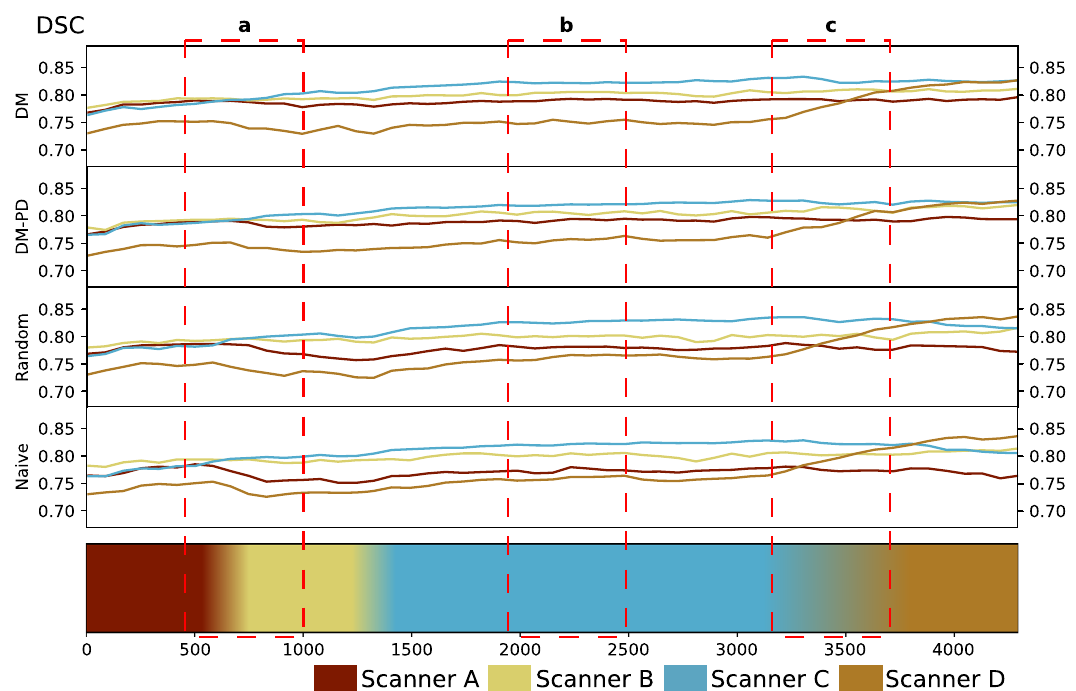
Fig. 2 Cardiac MR segmentation. Dice score (DSC) on the validation set during training for M = 128 for DM and DM-PD, compared to random replacement and naive continual learning. The timeline at the bottom represents a continuous data stream and the change of domains in the stream. a A drop of DSC for Scanner A can be observed when Scanner B occurs in the stream, DM and DM-PD were able to recover from this drop using the memory; b all methods are stable during training with Scanner C, and c as soon as Scanner D data fl ows in, we see a quick rise of DSC for Scanner D validation samples. Naive and random replacement lose some DSC points during that period, while DM remains stable. This signi fi cant and rapid change shows that Scanner D is different compared to the others and not as closely related as Scanner B and